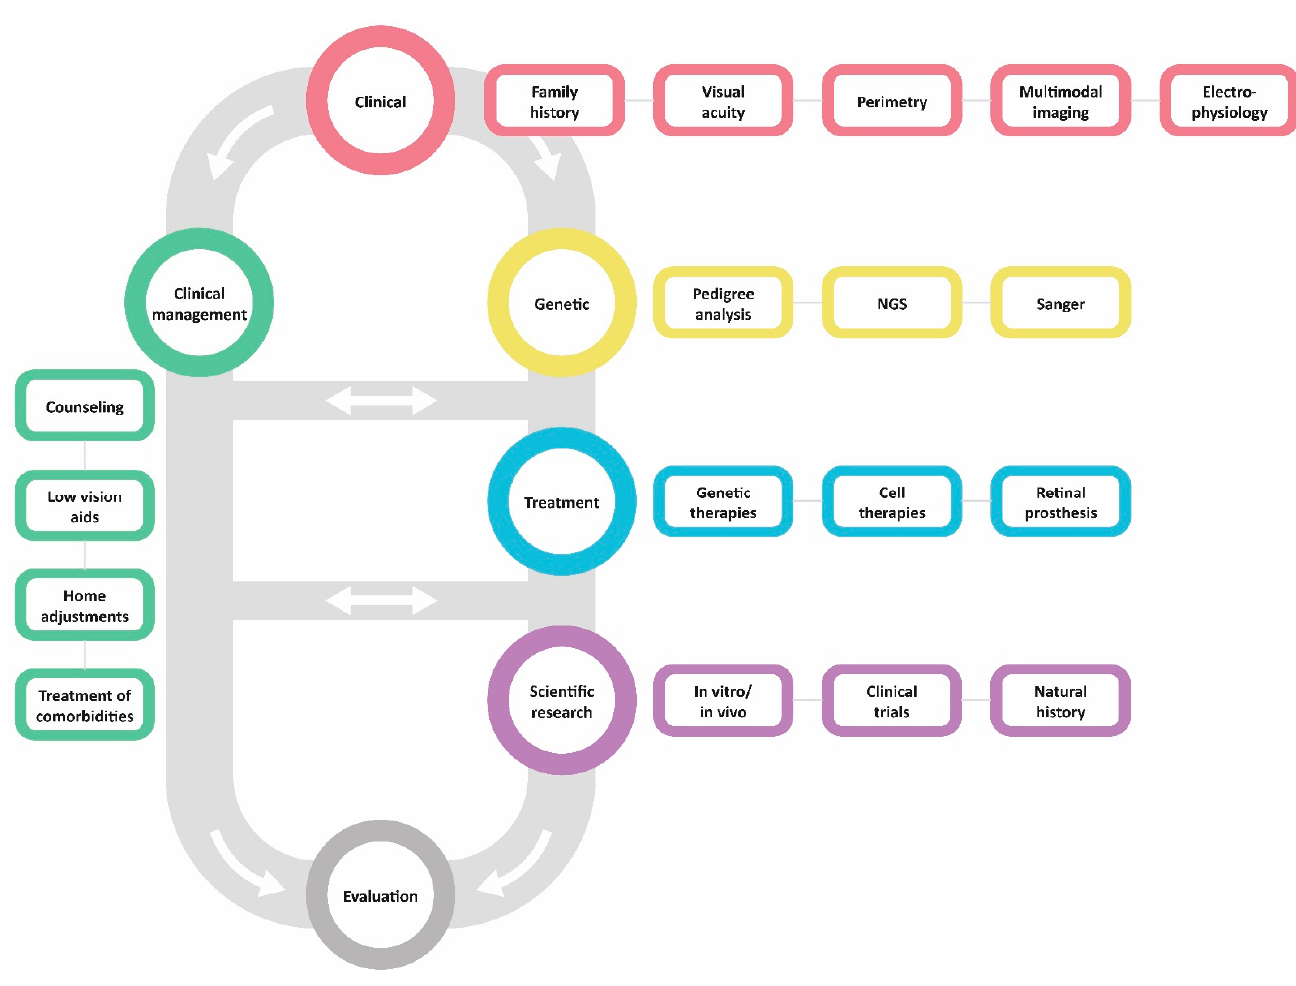
Figure 5. Flowchart demonstrating the clinical management of patients with retinitis pigmentosa (RP). The fi rst step should be identifying patients with possible RP clinically, after which genetic testing should be performed, when available, if a diagnosis of presumed RP is made. Simultane- ously, further clinical management should be o ff ered through counseling, low-vision aids, home adjustments and treatment of comorbidities. Depending on the underlying causal gene, symptoms and severity of RP, treatment eligibility is assessed. Additionally, patients may opt to participate in ongoing research. The landscape for RP continues to change, and regular follow-up is advised to remain up to date with current clinical management and novel